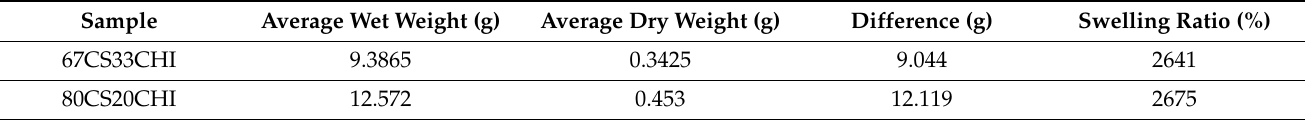
Table 1. Swelling ratio of synthesized hydrogels.